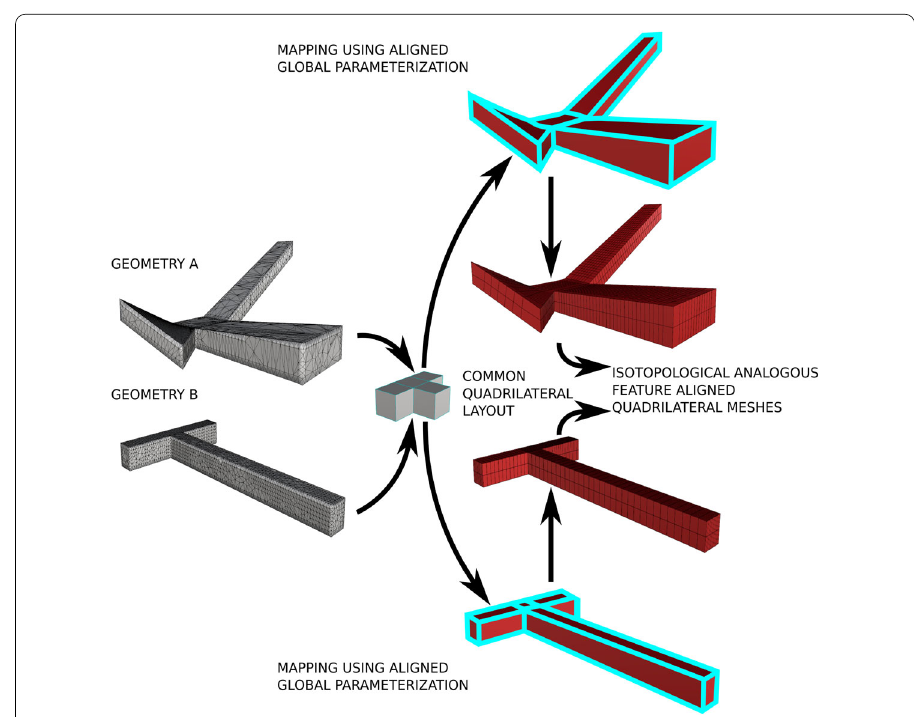
Fig. 2 The MEG-IsoQuad method. Building isotopological analogous feature-aligned quadrilateral meshes from triangulated meshes with the same topology. Resulting isotopological meshes have non-uniform